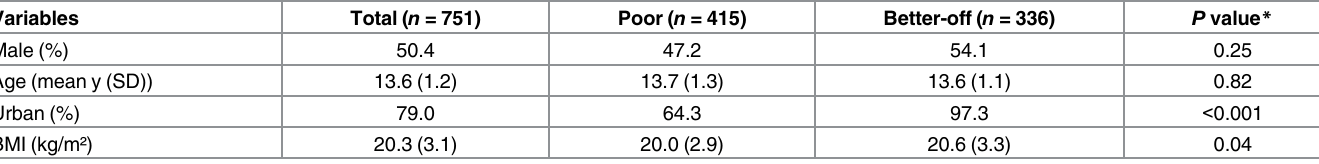
Table 1. Participant characteristics.